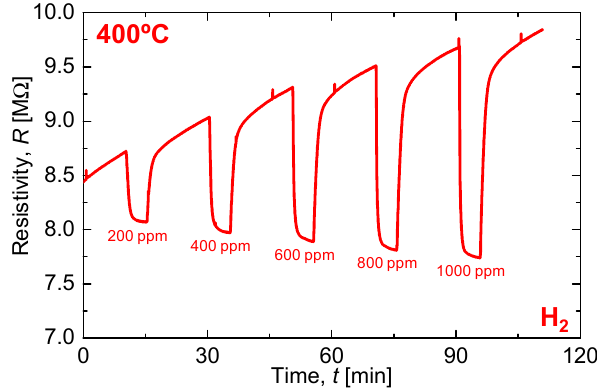
Figure 6. Sensor resistance change under various H 2 concentrations at 400 °C.